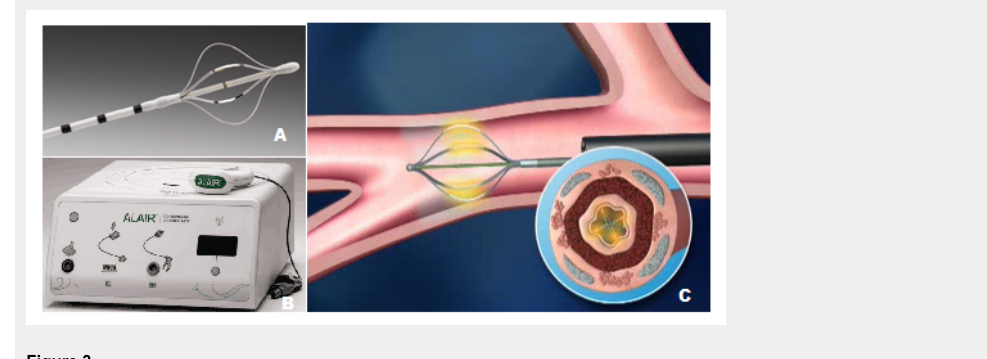
Figure 3 A- Alair Catheter; B- Alair RF Controller; C- Schematic representations of using the catheter.